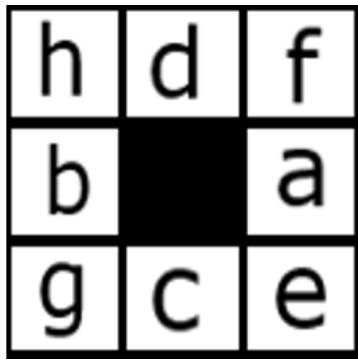
Figure 10. Demonstrating the traversal